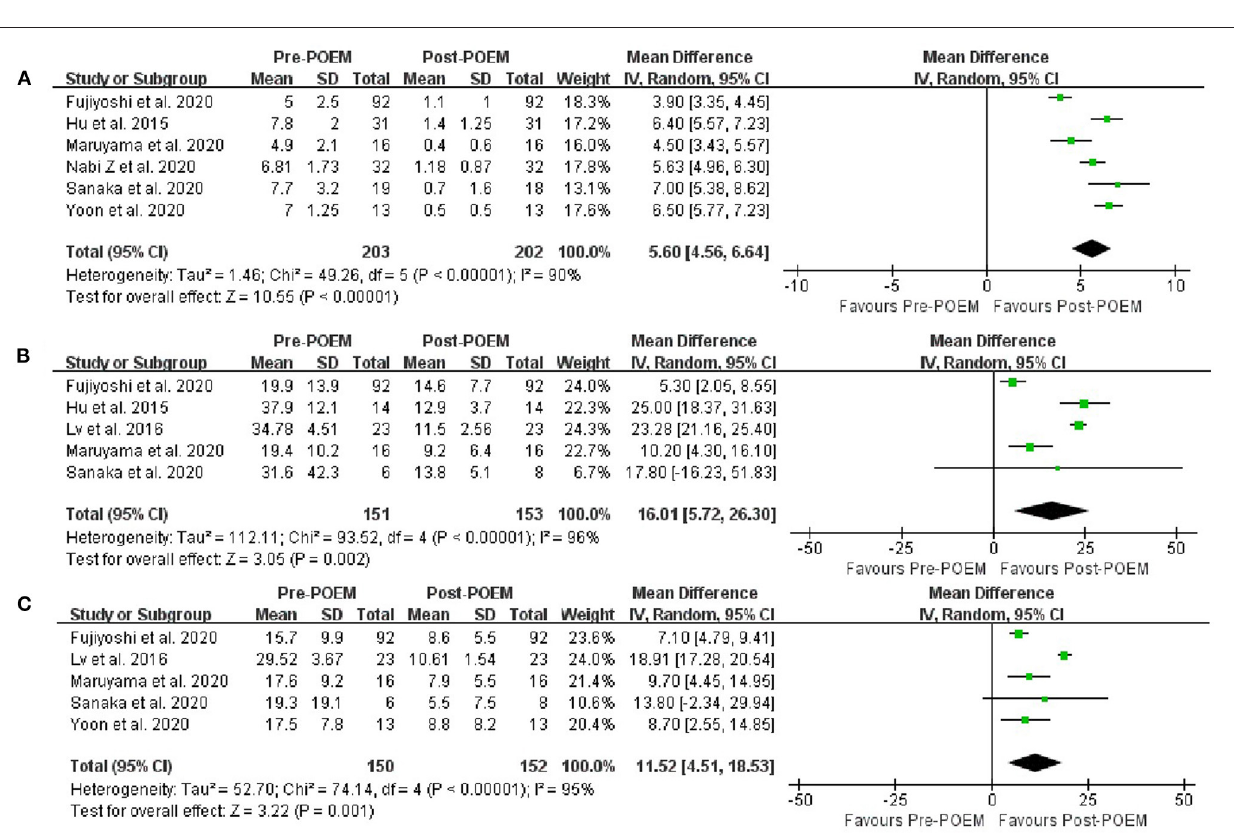
FIGURE 3 | (A) Meta-analysis of the changes in Eckardt score after POEM in sigmoid-type achalasia. (B) Meta-analysis of the changes in LES pressure after POEM in sigmoid-type achalasia. (C) Meta-analysis of the changes in IRP after POEM in sigmoid-type achalasia.